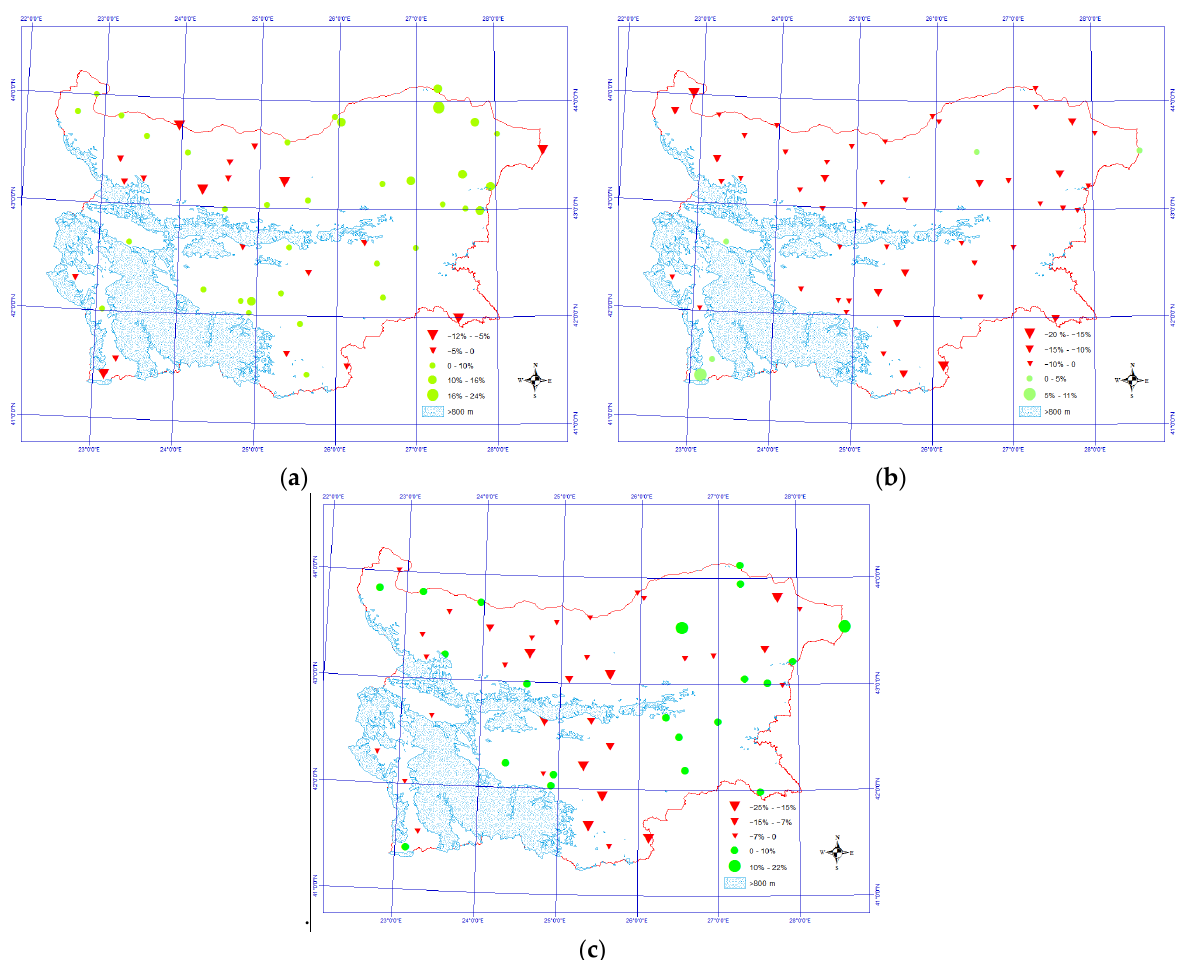
Figure 8. Deviations of rainfall sums during the periods: ( a ) October–March; ( b ) April–June; ( c ) June–August.